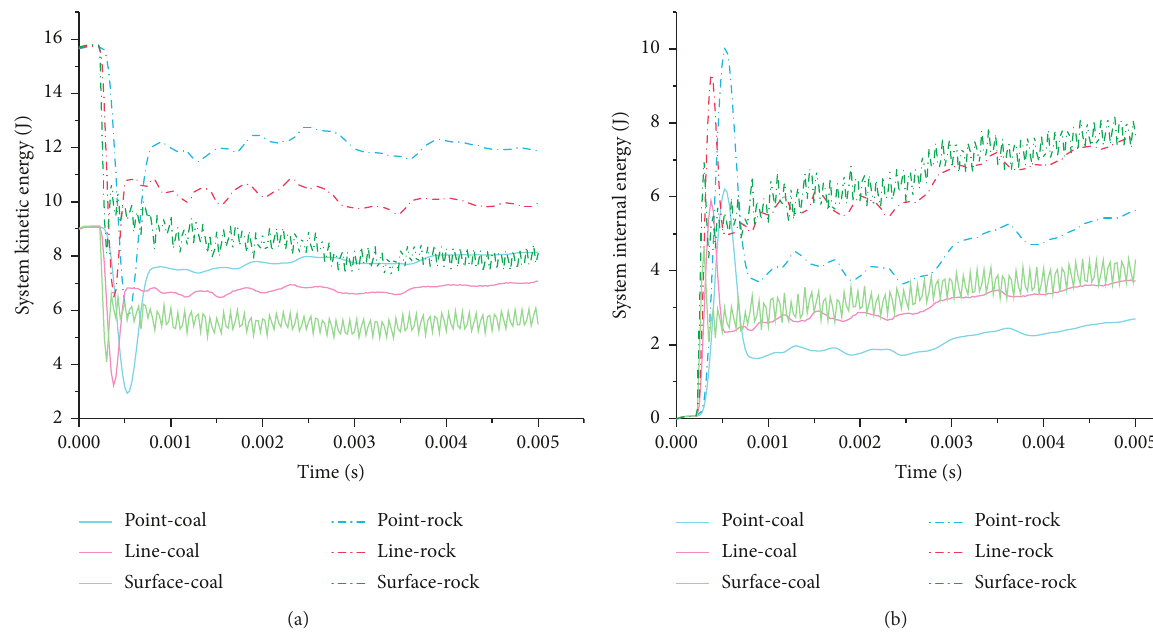
Figure 17: (a) System kinetic energy and (b) system internal energy under different contact modes.